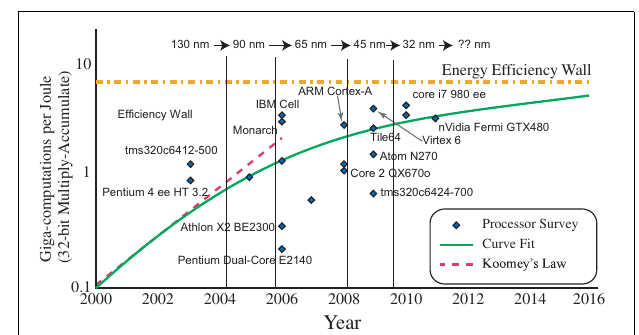
Year FIGURE 17 | Plots of computational efficiency for digital multiply accumulate (MAC) operations normalized to 32bit size computation. Over the last several years, the computational efficiency has not scaled along the lines expected by traditional Moore’s law type scaling. A closer look suggests an asymptote is being reached in MAC computational efficiency using classical digital techniques. The computation efficiency levels off below 10MMAC/mW (or 10GMAC/W or 100pJ per MAC). The asymptotic curve falls off from the linear trend at approximately